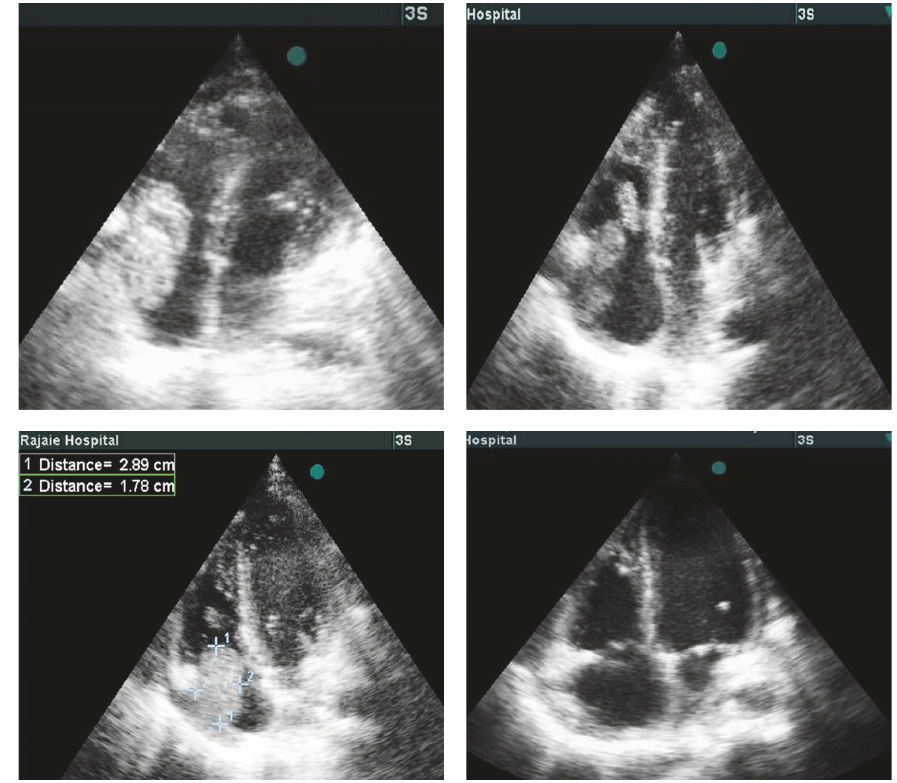
Figure 1: Right atrium vegetation in different view in echocardiography subcostal; four chamber views during systole and diastole. Note mobile position of mass that enters RV during diastole. Last image showed four chamber views after mass